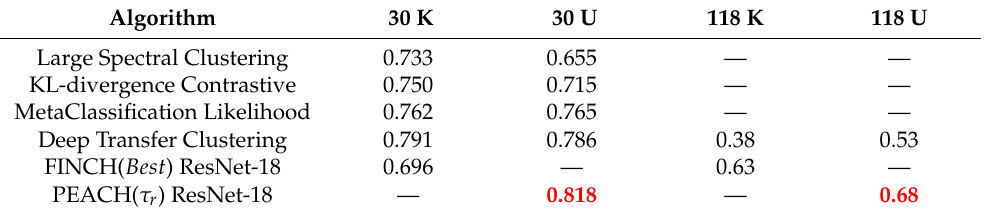
Table 3. PEACH Transfer Clustering. This table shows NMI on transfer clustering for ImageNet with partitions from [67] with either 800 training and 82 validation classes and three random samples with 30 classes for testing, or 882 training and 118 test classes. Results with K used the ground- truth number of clusters, while U indicates estimated cluster counts, partially by [5]. We mark the best results